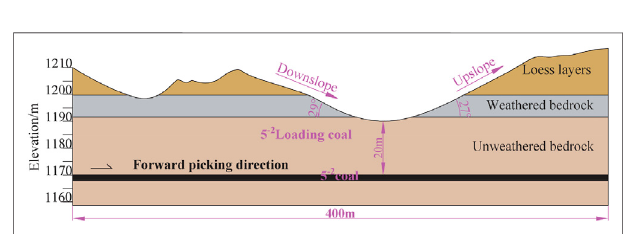
FIGURE 2 | Pro fi le of the over-gully section of the working face in the study site.